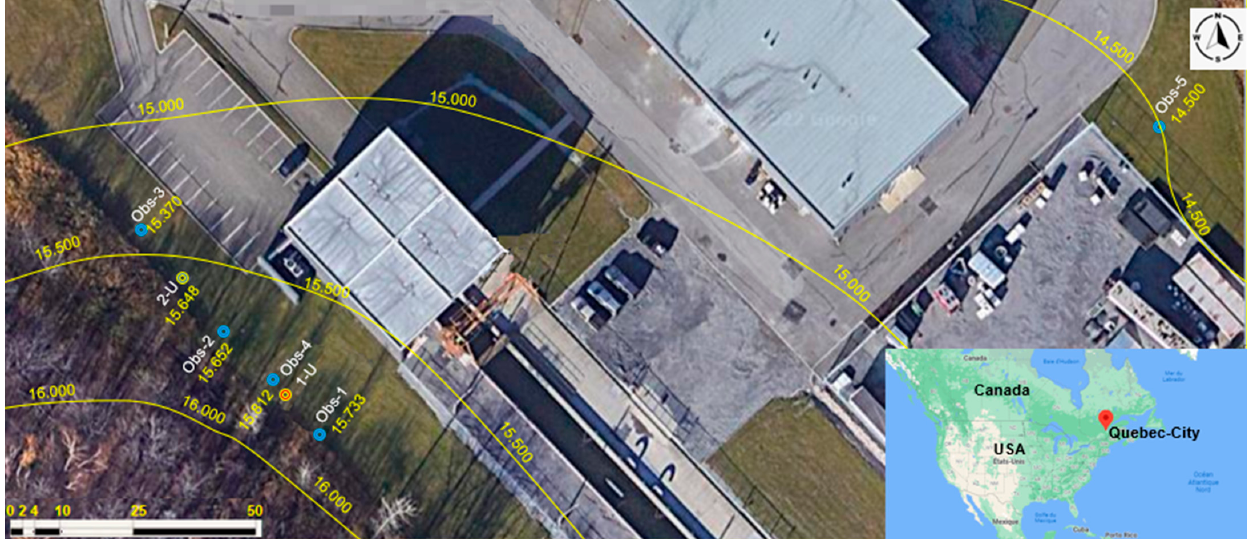
Figure 4. Geothermal experimental site at INRS (Quebec City). Numbers beside boreholes (obs and U) and along yellow lines indicate elevation of the water table in meters above the sea level and local potentiometric level, respectively See field set up in [11]. Obs are four open observation wells, while 1-Uand 2-U are the borehole heat exchangers.